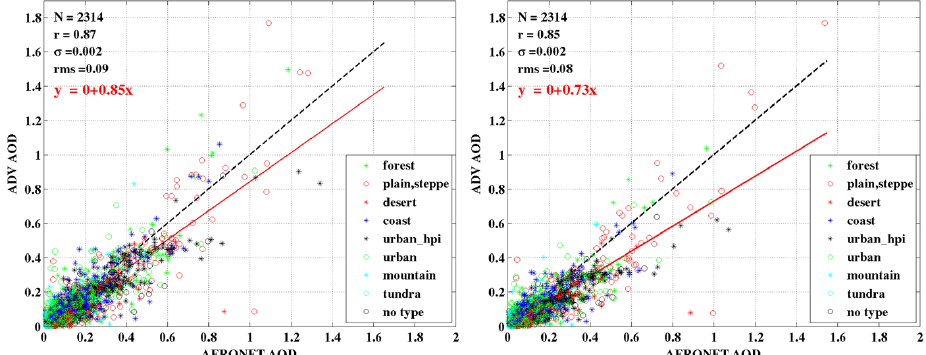
Figure 2. Validation of the AOD at 555nm (left) and at 659nm (right) retrieved from AATSR using ADV against AERONET AOD for year 2007. Colors and symbols relate to different surface types as explained in the